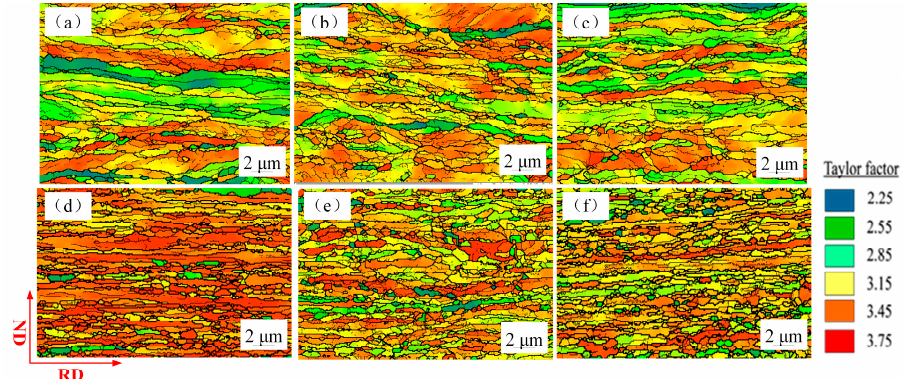
Figure 12. Distribution of Taylor factor of the samples with the thicknesses of ( a ) 600 µm, ( b ) 400 µm, ( c ) 200 µm, ( d ) 80 µm, ( e ) 40 µm, ( f ) 20 µm.